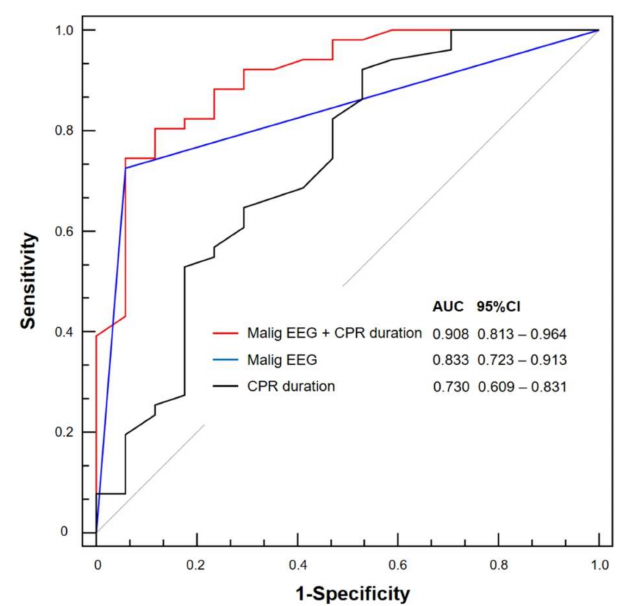
Figure3. Receiveroperatingcharacteristiccurvesforpredictingpooroutcomesusingmalignantpatterns of electroencephalography (EEG) and cardiopulmonary resuscitation (CPR) duration. Although there were no di ff erences between the areas under the curve (AUCs) of malignant EEG patterns and CPR duration, the performance of a composite of these marker was strongly associated with poor neurological outcomes compared with the use of either marker alone ( p = 0.008 and p = 0.006, respectively). CI, confidence interval; Malig EEG, malignant EEG